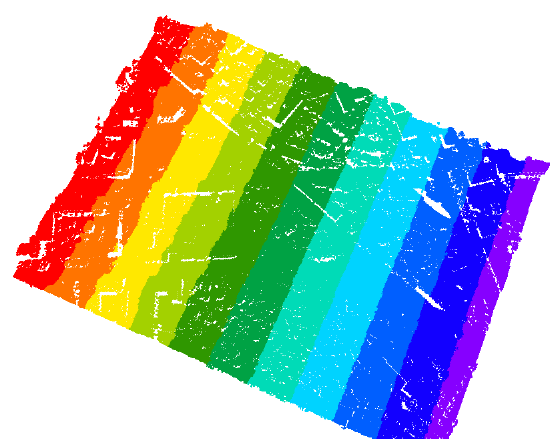
Figure 2 Test data used in the experiments